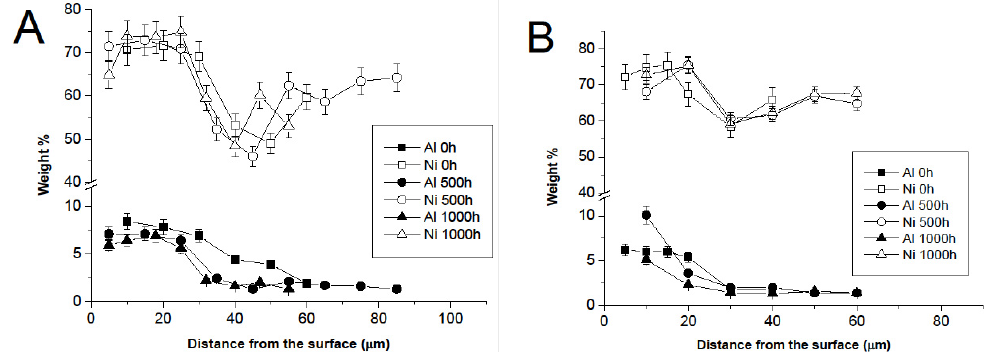
Figure 4. Compositional profiles of Al (full symbols) and Ni (empty symbols) for the cross sections depicted in Figure 1 as determined by EDS measurement. ( A ) and ( B ) panels depict data for IN738 + pack aluminizing + heat treatment and IN738 + IL aluminizing + heat treatment, respectively.